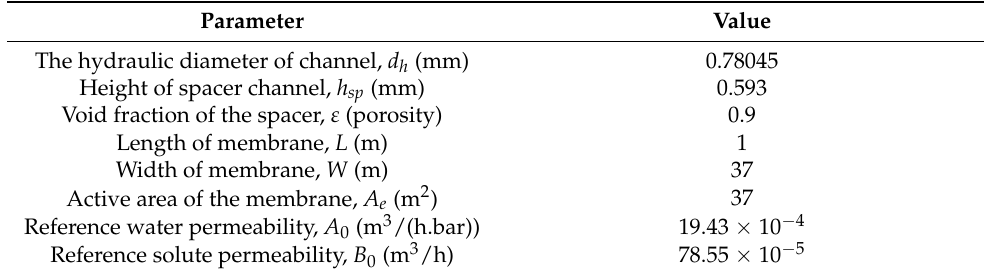
Table 1. Geometric Specification of the Membrane Module [35]. Parameter Value The hydraulic diameter of channel, d h (mm) 0.78045 Height of spacer channel, h sp (mm) 0.593 Void fraction of the spacer, ε (porosity) 0.9 Length of membrane, L (m) 1 Width of membrane, W (m) 37 Active area of the membrane, A e (m 2 ) 37 Reference water permeability, A 0 (m 3 /(h.bar)) 19.43 × 10 − 4 Reference solute permeability, B 0 (m 3 /h) 78.55 × 10 −